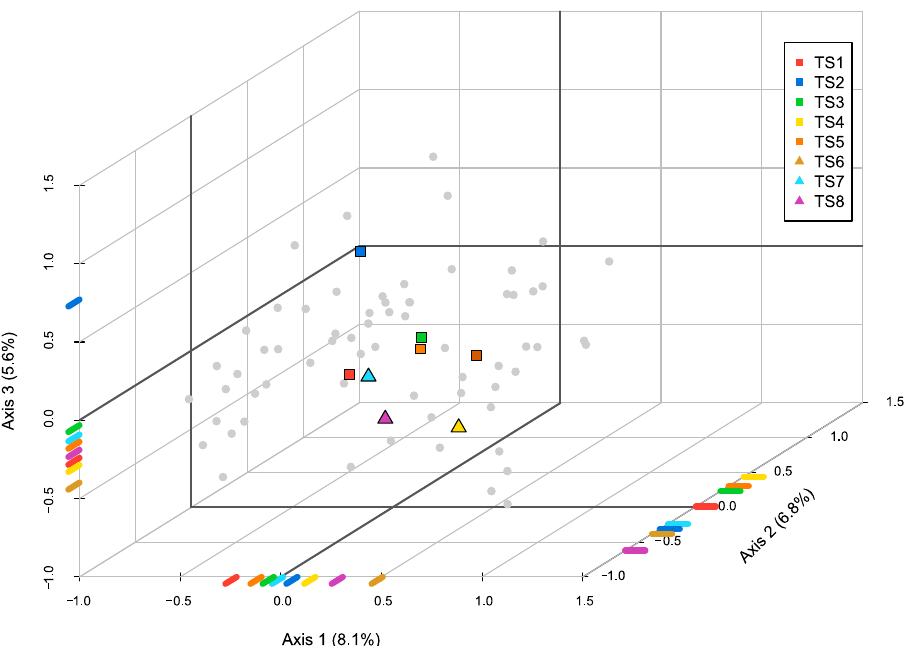
Figure 7. Results of the fuzzy correspondence analysis (FCA) applied to the fish “species × trait” table. The average paragons best representing each trait syndrome have been projected—as supplementary individuals—on the space defined by the first three factorial axes (total explained variance in %). TS i corresponds to the trait syndrome i (with i = 1–8) identified by cluster analysis (Figure 4). Squares and triangles correspond to TS with mainly positive or negative correlations with micropollutants, respectively. Tags indicate the position of each paragon on the different